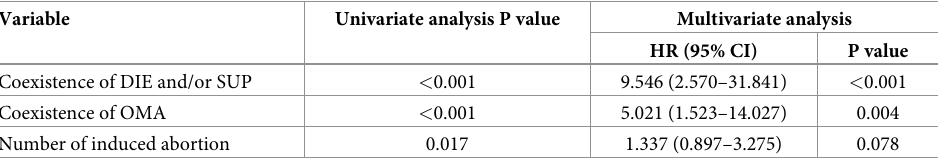
Table 3. Univariate and multivariate analysis to identify independent predictors of the early stages of extrinsic